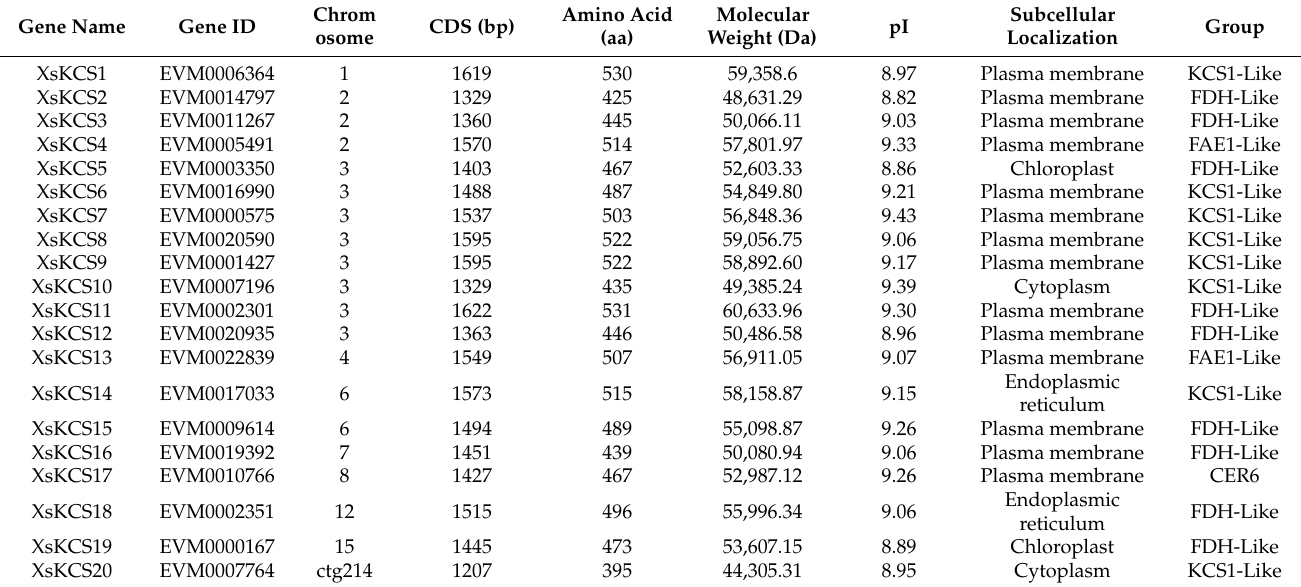
Table 1. Physicochemical properties and subcellular localization of XsKCS